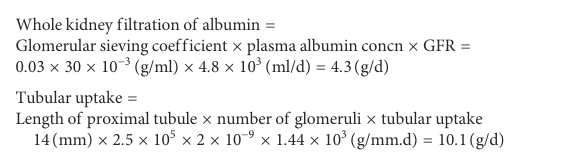
TABLE 1 A calculation of the amount of albumin fi ltered by rabbit kidneys (g per day) as compared to potential tubular uptake of fi ltered albumin by the high capacity receptor. The high glomerular sieving coef fi cient for albumin of 0.03 is explained in the text. The number of glomeruli in rabbit kidneys comes from Moore and Hellman (1931).